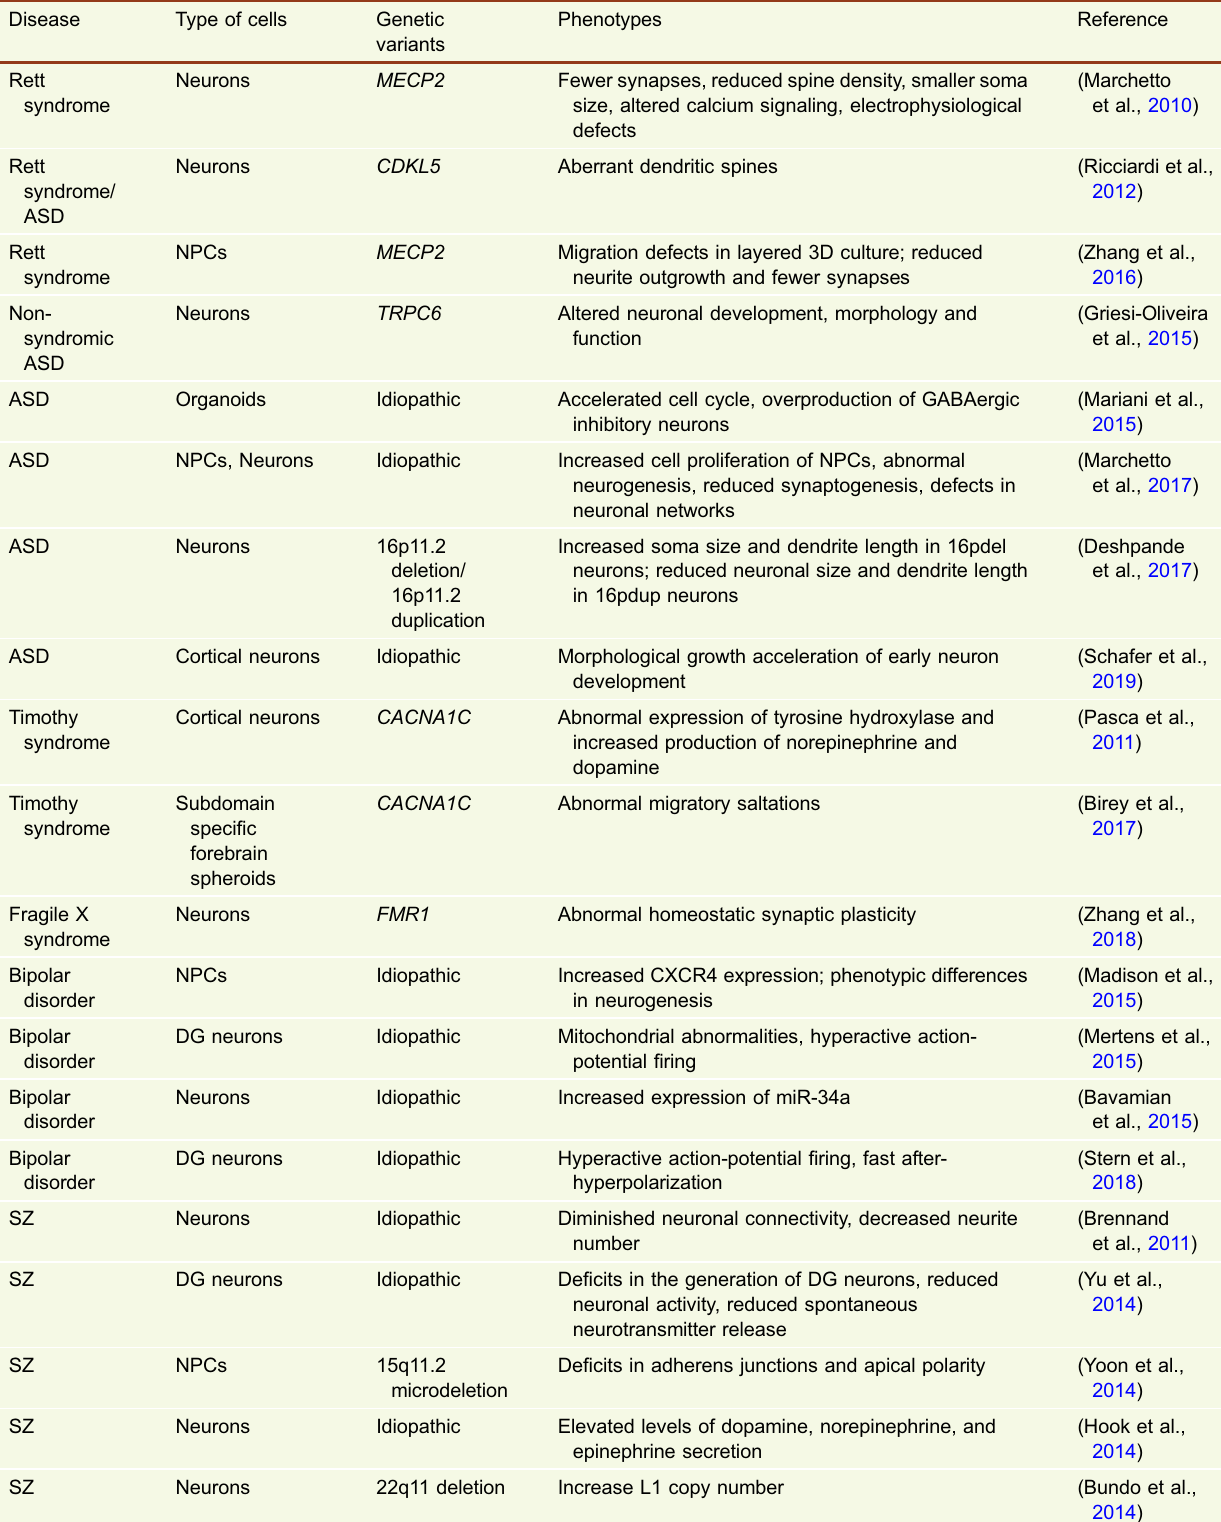
Table 1. Selected studies investigating neuropsychiatric disorders using hiPSCs from patients.